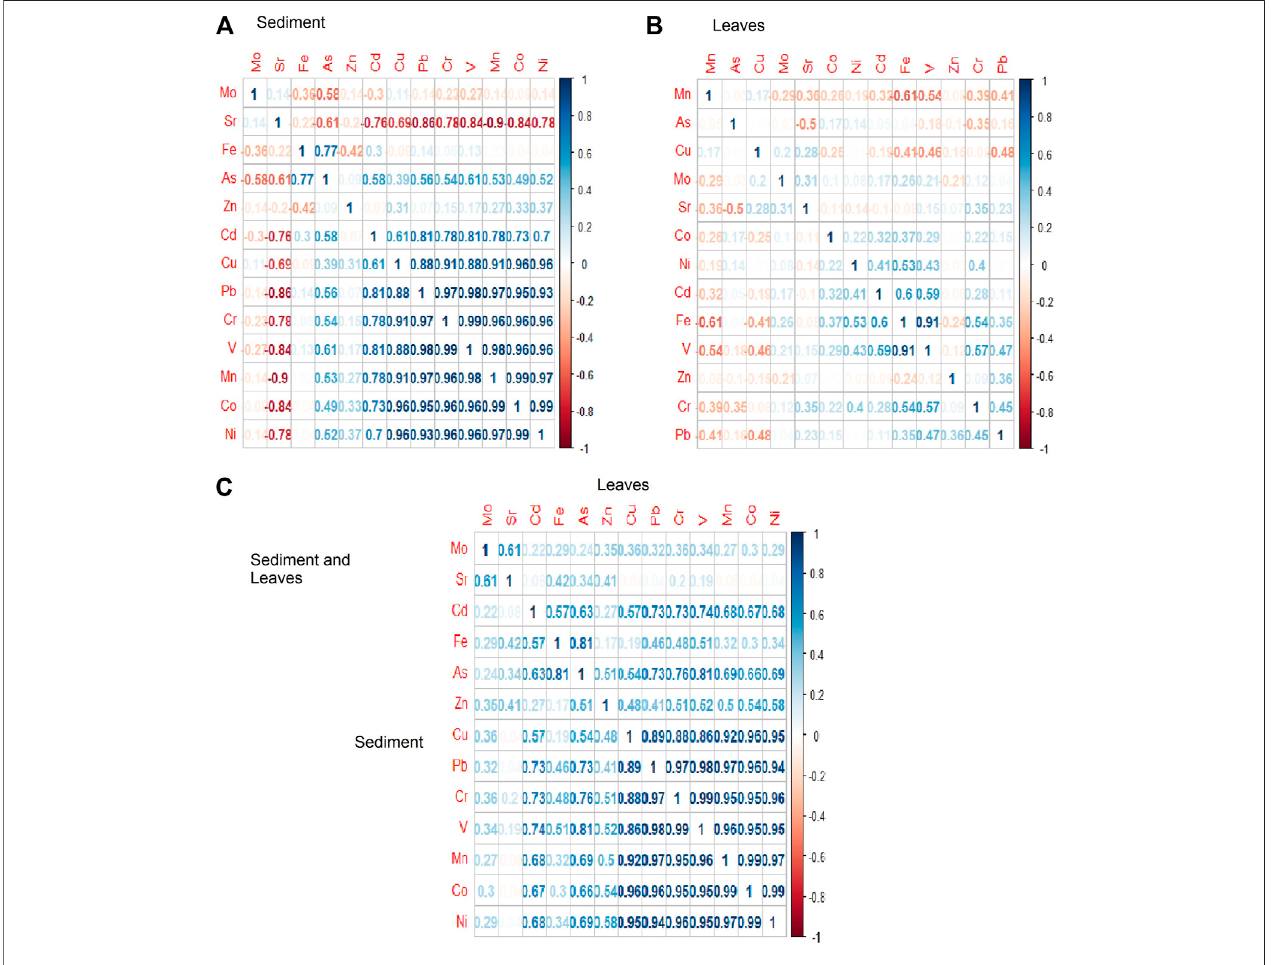
FIGURE 2 | Correlation (r) matrix for metal concentrations in the sediment (A) , leaves (B) , and between metals in sediment and leaves (C) .